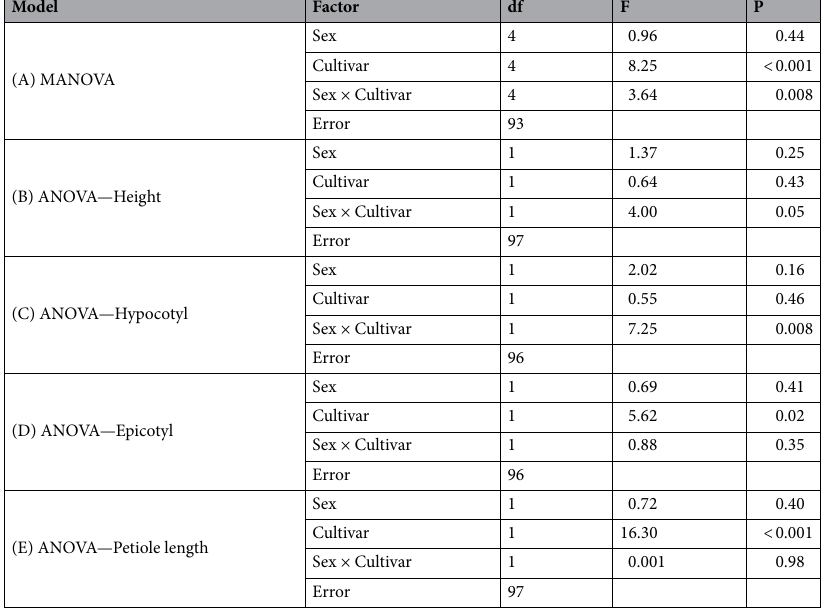
Table 1. Multivariate analysis of variance (MANOVA) comparing the physical differences in three traits between male and female plants (factor: sex) of two cultivars (CFX-1, CFX-2) of hemp. Analysis of variance (ANOVA) was used to compare combinations of experimental factors (sex, cultivar and their combination). Response variables (four phenotypic traits: height, hypocotyl length, epicotyl length, petiole length) were natural log transformed. F-value is the test statistic used, p-value is the related probability of the null hypothesis being true based on the analysed observations, and df is the associated degrees of freedom.